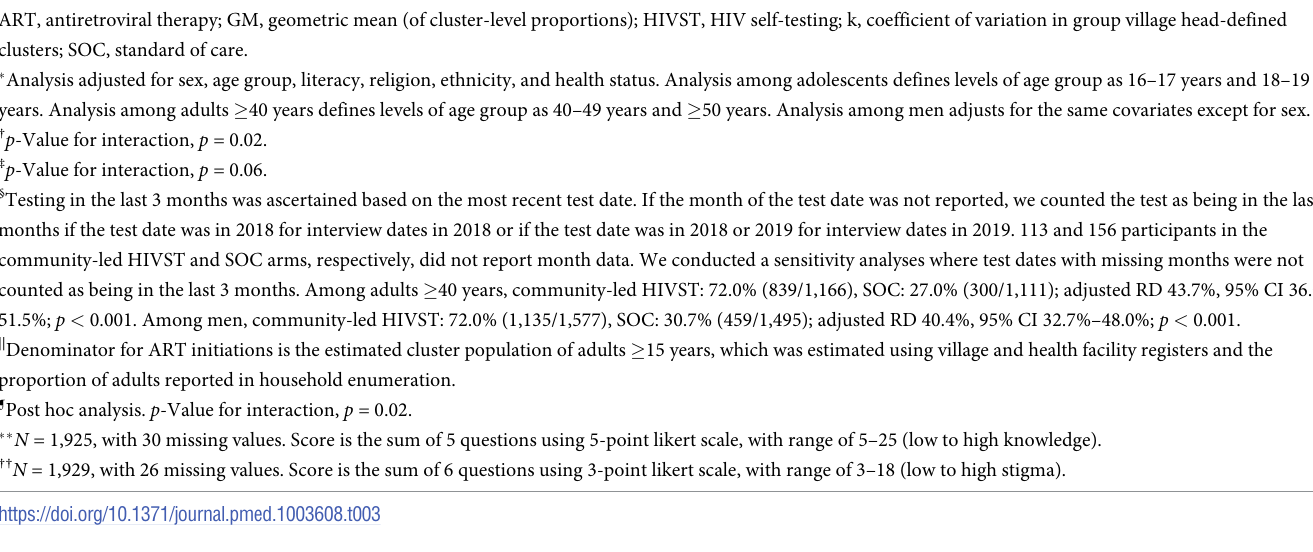
40.0% ( n = 28) were newly identified and 11.4% ( n = 8) were previously diagnosed and not on treatment. Self-reported ART initiation was 58.3% (21/36).